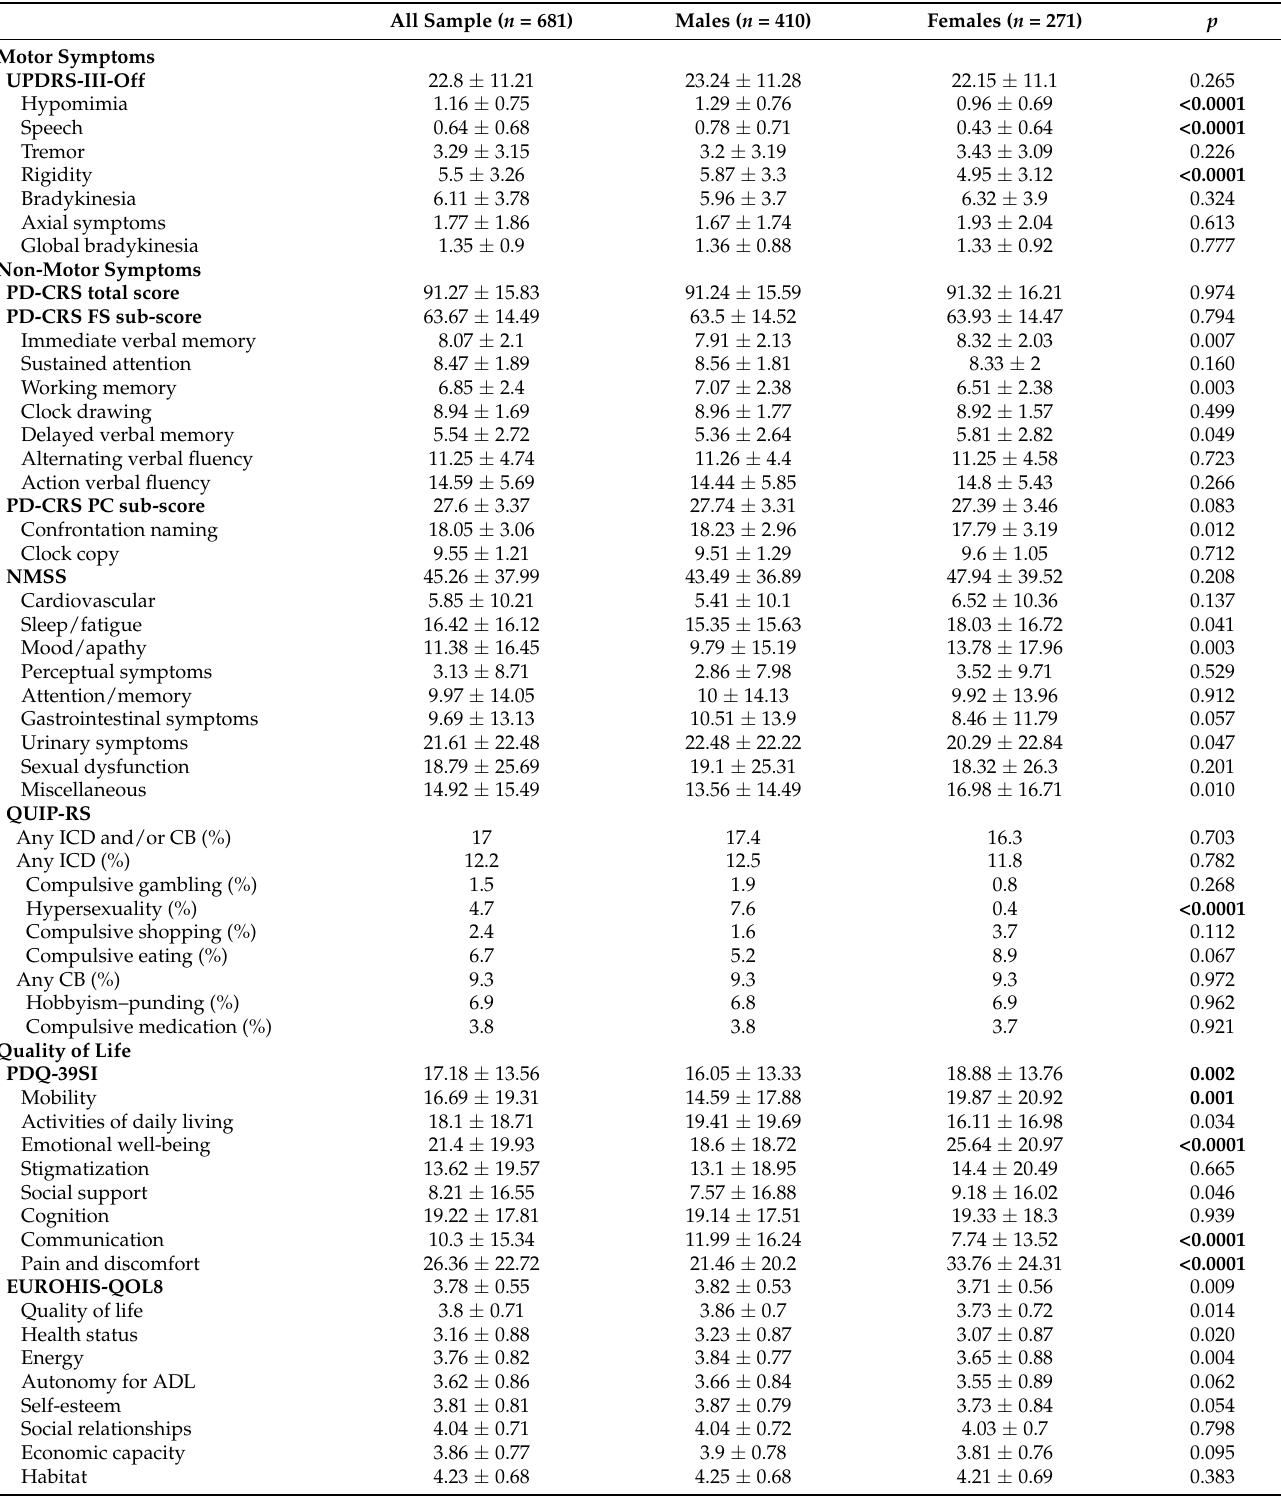
Table 3. Differences in motor aspects, cognition, impulsive-compulsive behaviors, and QoL between men and women with PD from the COPPADIS cohort at baseline (V0) ( n = 681). All Sample ( n = 681) Males ( n = 410) Females ( n =